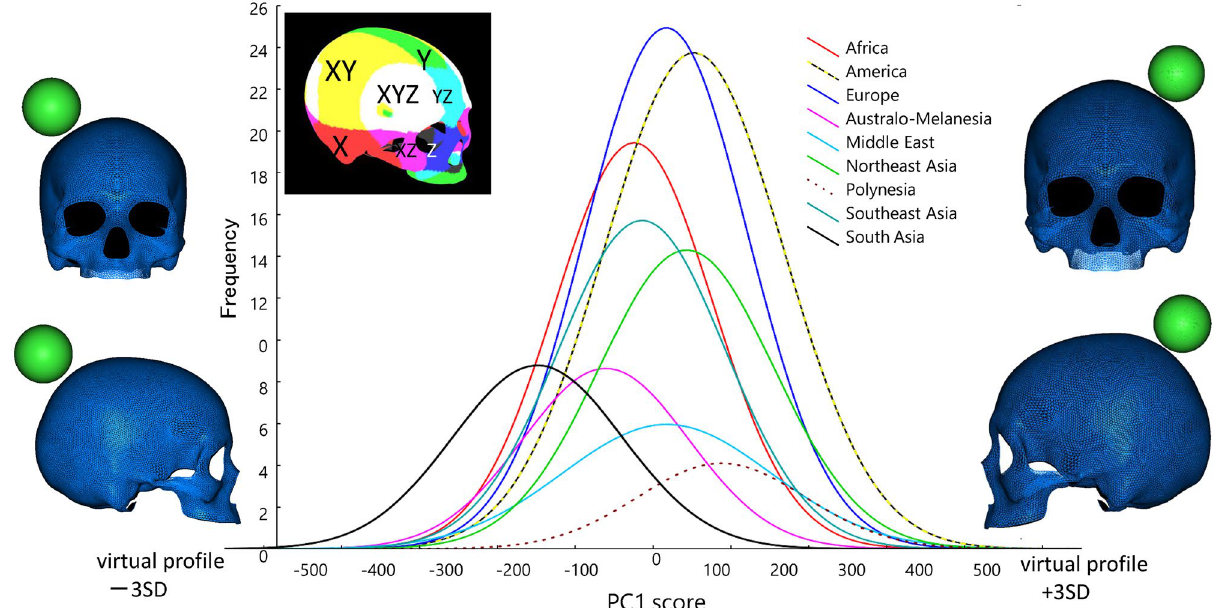
Figure 3. Frequency distribution (normal fit curve) for PC1 scores of 342 male cranial individuals worldwide, a color map of cranial surface highly correlating vertices to PC1 (interpretation of color against X, Y, Z axis: see text), and virtual shape deformations with a magnitude of 3 SD at the opposite sides of this axis. The scale is given as a green colored sphere of 50 mm in